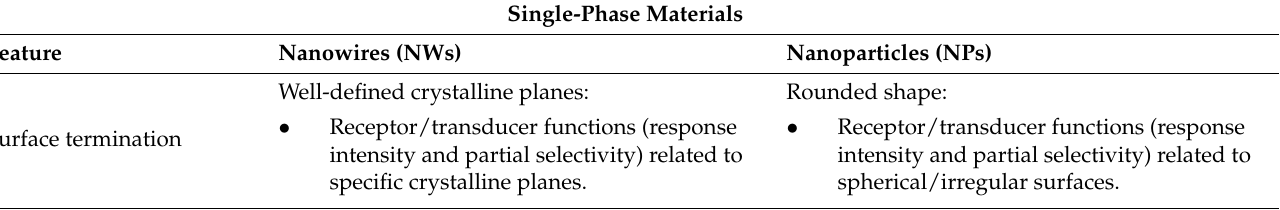
Table 8. Resumed comparison between nanowires (NWs) and nanoparticles (NPs), relationship between the structural/morphological properties and the related gas-sensing phenomena and